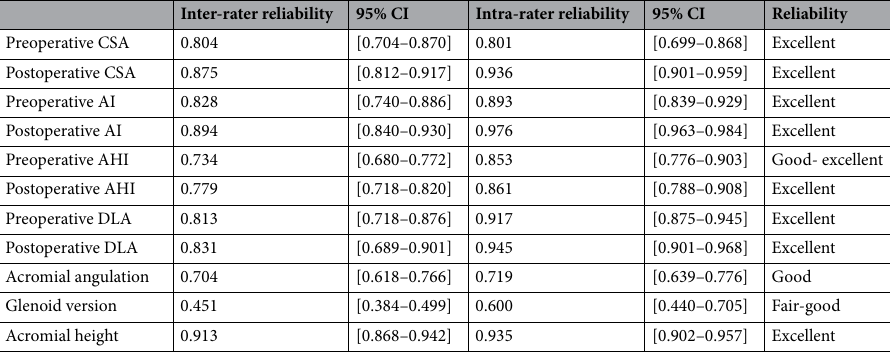
Table 2. Inter- and intra-rater reliability for all radiographic measurements and mean values for radiographic analysis. CI confidence interval, CSA critical shoulder angle, AI acromial index, AHI acromiohumeral interval, DLA deltoid lever arm.